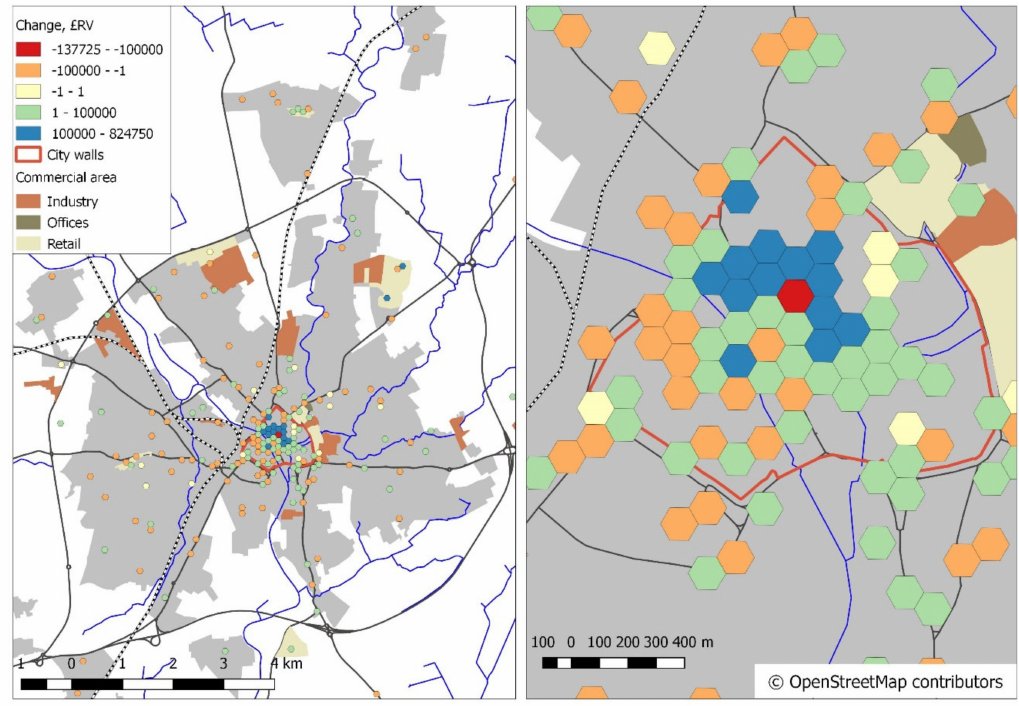
Figure 13. Change in food and drink RV,